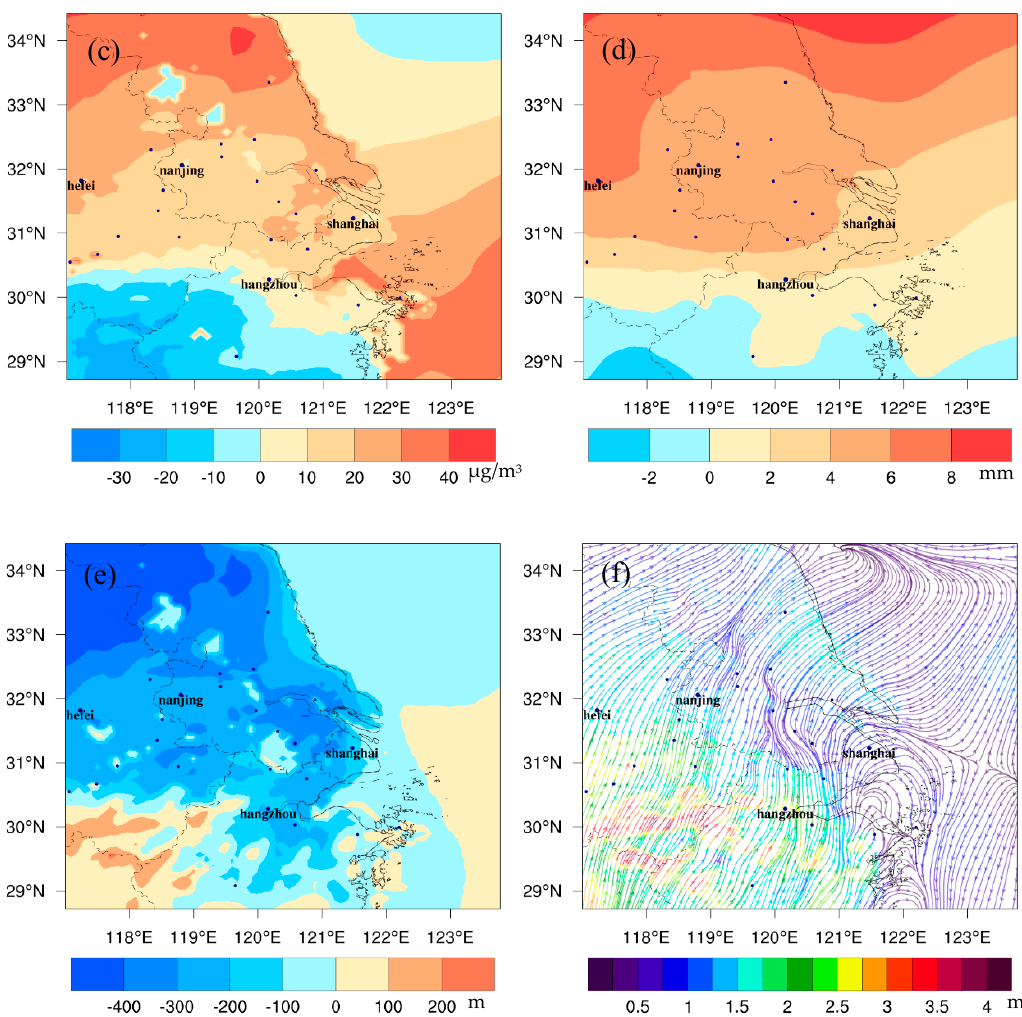
Figure 2. The spatial distribution of the monthly averaged differences of ( a ) solar radiation, ( b ) 2-m air temperature, ( c ) precipitation, ( d ) 2-m absolute humidity, ( e ) planetary boundary layer height, and ( f ) 10-m wind fields between future meteorology in 2050, 2051, and 2052 and the present emission (FUTMET) and the present meteorology in 2014, 2015, and 2016 and the present (PREMET) during the daytime (from 7:00 to 18:00 LST).